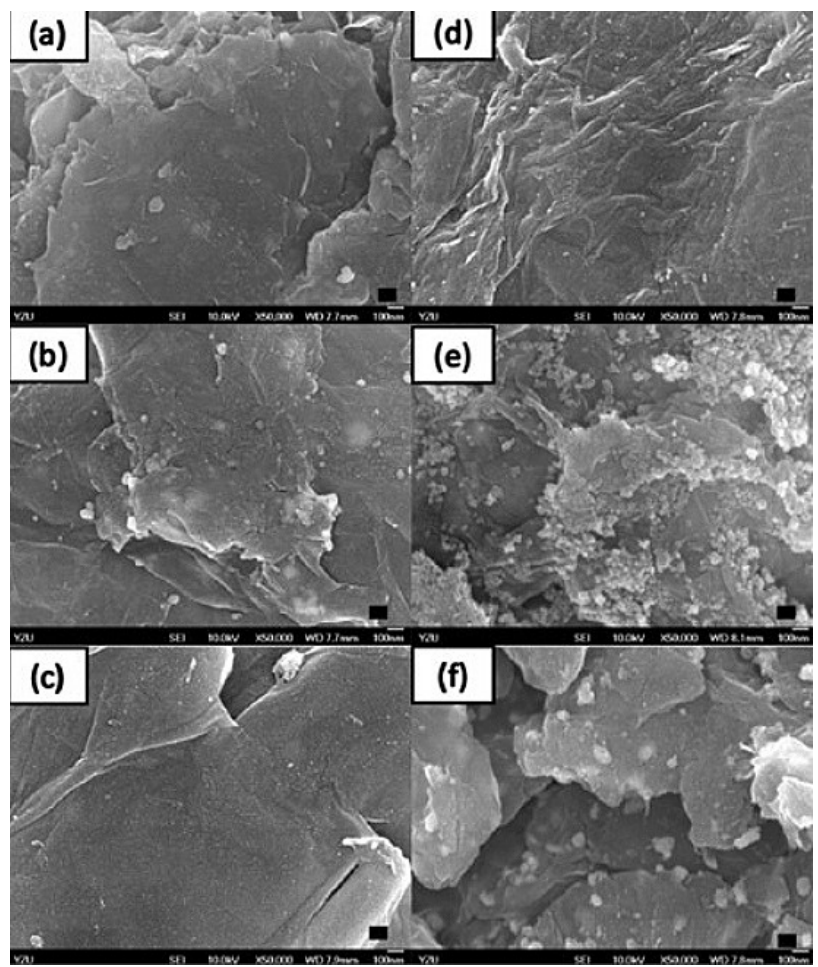
Figure 5. Scanning electron microscopy images of ( a ) 5.34% silver nanoparticle-embedded graphene oxide (Ag/rGO), ( b ) 7.49% Ag/rGO, ( c ) 6.85% zinc oxide nanoparticle-embedded graphene oxide (ZnO/rGO), ( d ) 16.45% ZnO/rGO, ( e ) 3.47% silver nanoparticle, and 34.91% zinc oxide nanoparticle-embedded graphene oxide (Ag/ZnO/rGO), and ( f ) 7.08% silver nanoparticle and 15.28% zinc oxide nanoparticle-embedded graphene oxide (Ag/ZnO/rGO). Adapted from reference [142].